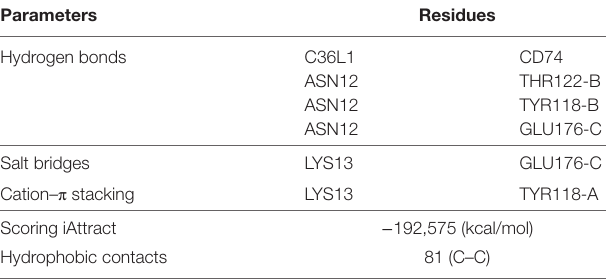
TaBle 1 | Molecular docking main